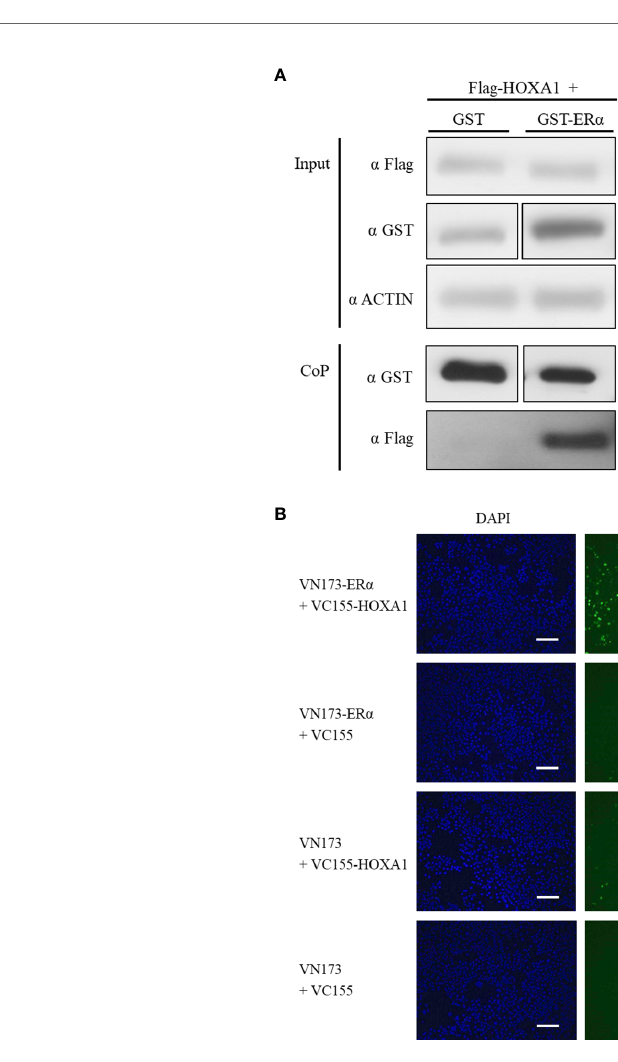
FIGURE 5 | Interaction between human HOXA1 and ER a in co-precipitation and BiFC assays. (A) For co-precipitation assays, HEK293T cells were transfected with plasmids encoding Flag-HOXA1 and GST or GST-ER a . Protein abundance was monitored prior to co-precipitation with anti-Flag and anti-GST antibodies (Input). b -actin was used as a loading control. After co-precipitation (CoP), Flag-HOXA1 is retrieved by precipitating GST-ER a on glutathione beads, while not with GST alone (N=6, n=1). (B) For BiFC assays, COS7 cells were transfected with plasmids encoding human HOXA1 and ER a respectively fused with VC155 and VN173. Unfused VC155 and VN173 were used for negative controls. BiFC signal is observed when VC155-HOXA1 and VN173-ER a are transfected together, while not in negative controls. The insert shows that the BiFC signal provided by the VC155-HOXA1 and VN173-ER a interaction is nuclear (N=4, n=1). Scale bars represent 200 µm; N, number of experiments; n, number of replicates per